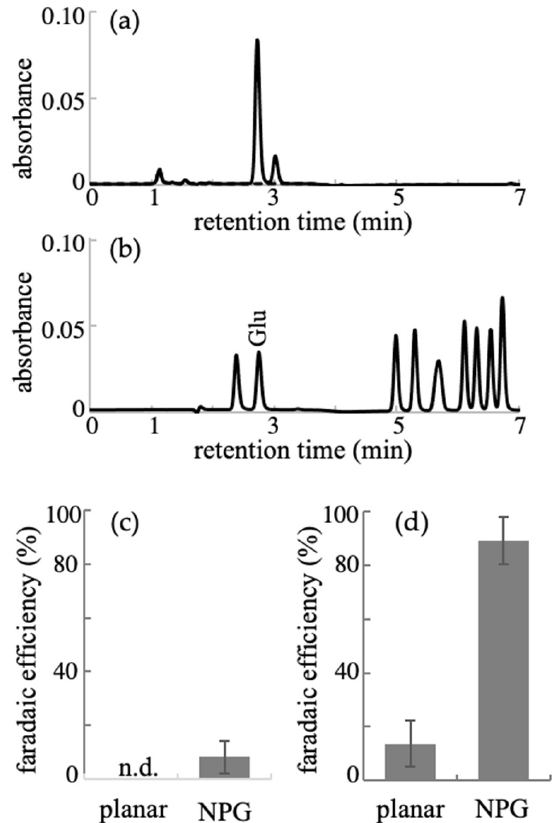
Figure 3. Typical HPLC chromatograms of ( a ) electrolyzed solution for 50 mM of α -ketoglutaric acid in the presence of 50 mM of NH 2 OH using anodized NPG electrode for 30 min and ( b ) standard solutions containing 1 nmol of L-amino acids. The dotted line in ( a ) indicates the chromatogram of the solution before electrolysis. Faradaic efficiency (FE) for electrochemical production of L-glutamic acid at planar-gold and NPG electrodes in the presence of ( c ) NH 3 and ( d ) NH 2 OH as nitrogen sources. EF values are represented as mean ± SD ( n = 3 independent experiments). “n.d.” means not detected.